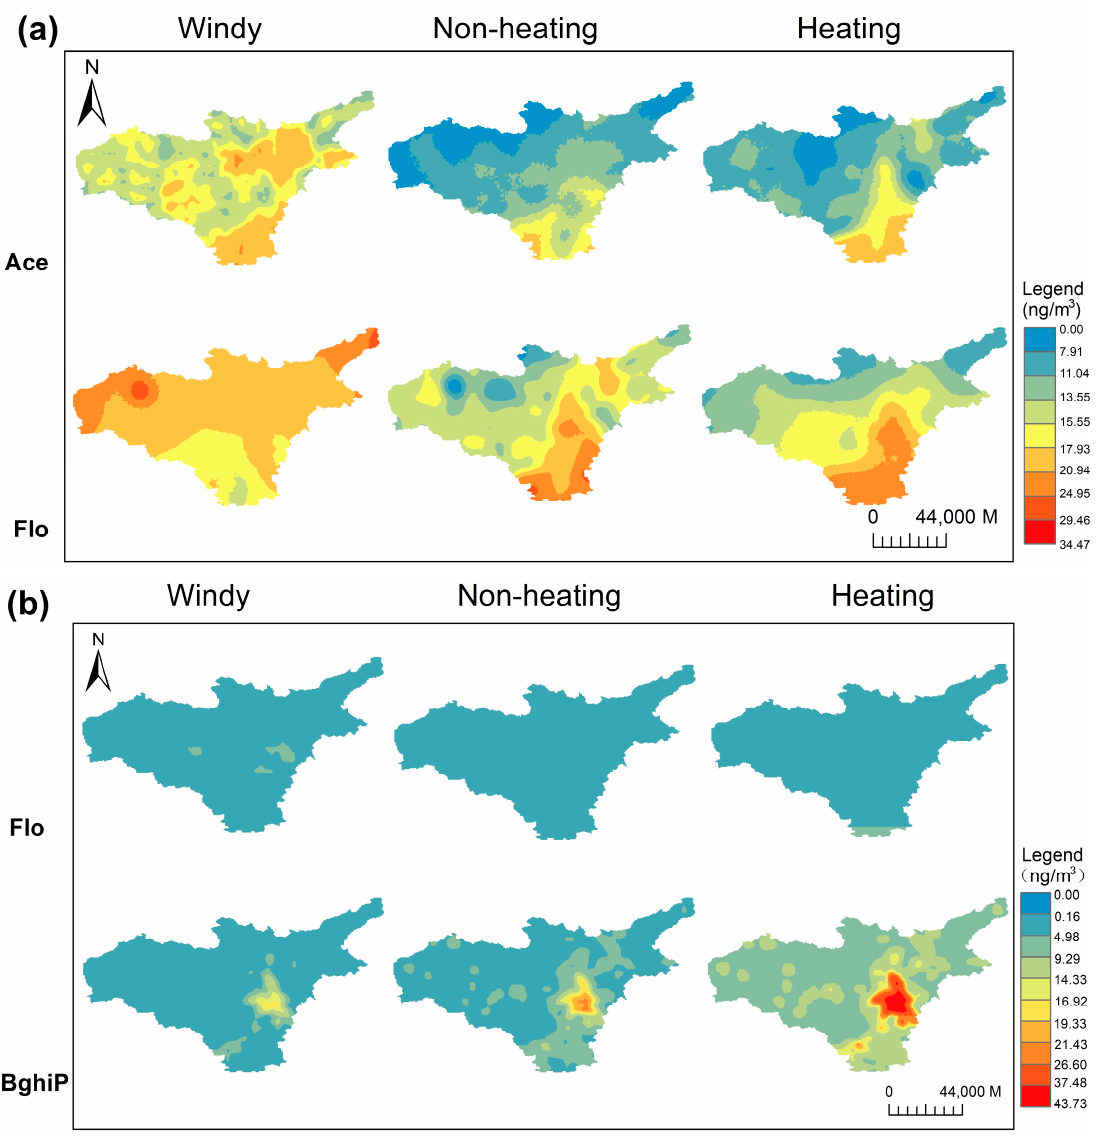
Figure 5. LUR exposure surfaces in three seasons (from left to right: windy season, non-heating season, heating season). Where ( a ) represents PAHs in the gas phase and ( b ) represents PAHs in the particulate phase.